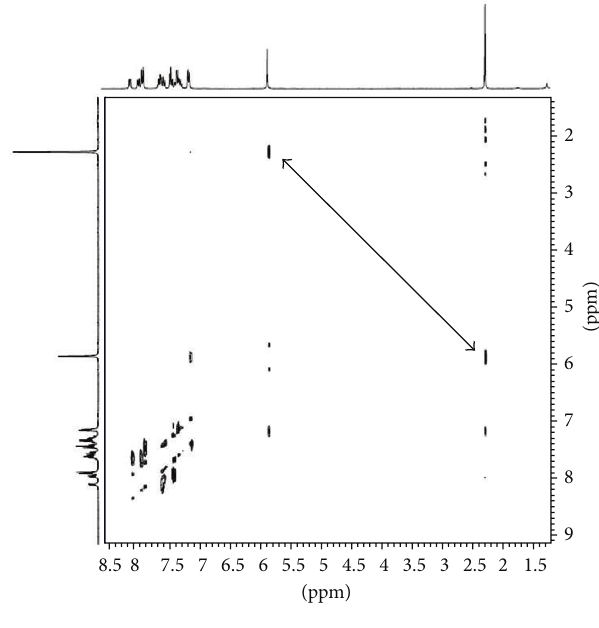
Figure 3: NOESY spectrum of compound 4g